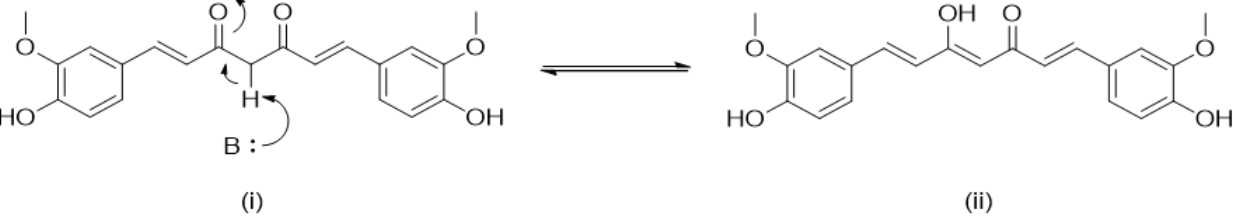
Figure 6. The equilibrium between the ( i ) keto and ( ii ) enolate forms of curcumin due to the reactivity of the methylene 𝛼-hydrogen, which is susceptible to nucleophilic attack, leading to the low stability of curcumin [45,53,54].